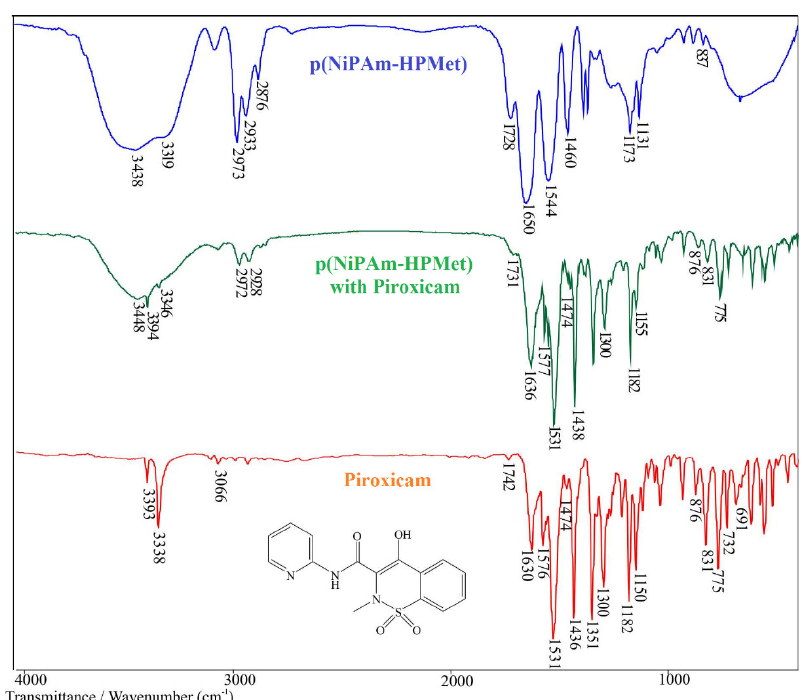
Figure 3. FTIR spectra of: pure p(NiPAm-HPMet) hydrogel, p(NiPAm-HPMet) hydrogel with incorporated piroxicam and piroxicam with the structural formula. 2.5.2. FTIR Spectrum Analysis of p(NiPAm-HPMet) with Incorporated Piroxicam Table 7. Positions of characteristic absorption band maximums for p(NiPAm-HPMet), pirox- icam p(NiPAm-HPMet), with incorporated piroxicam and value of wavelengths shifts after drug